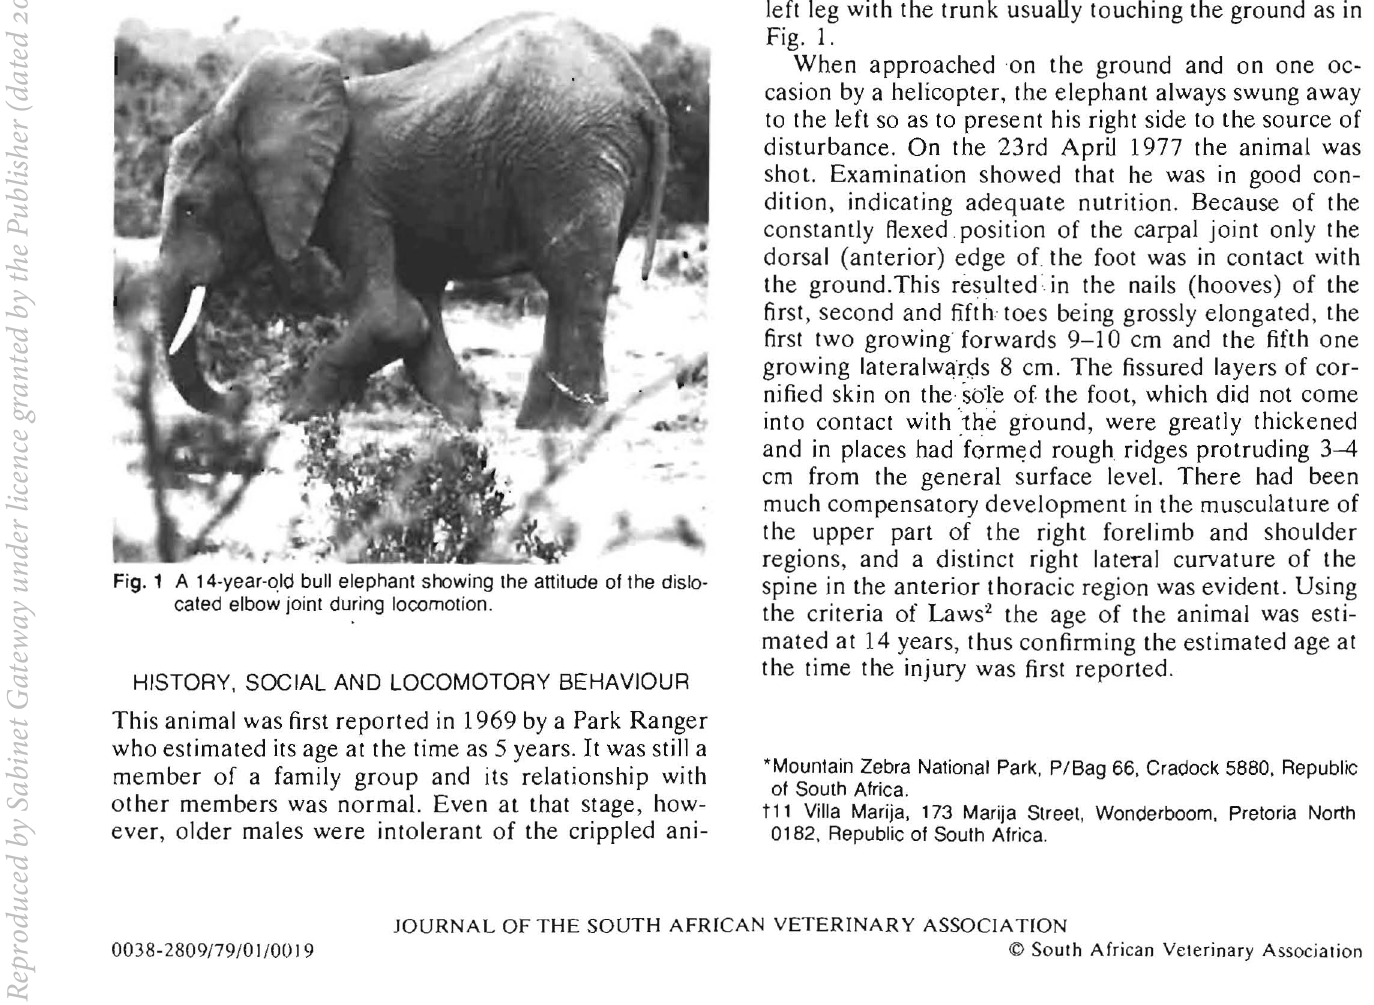
Fig. 1 A 14-year·old bull elephant showing the attitude of the dislo· cated elbow joint during locomotion.